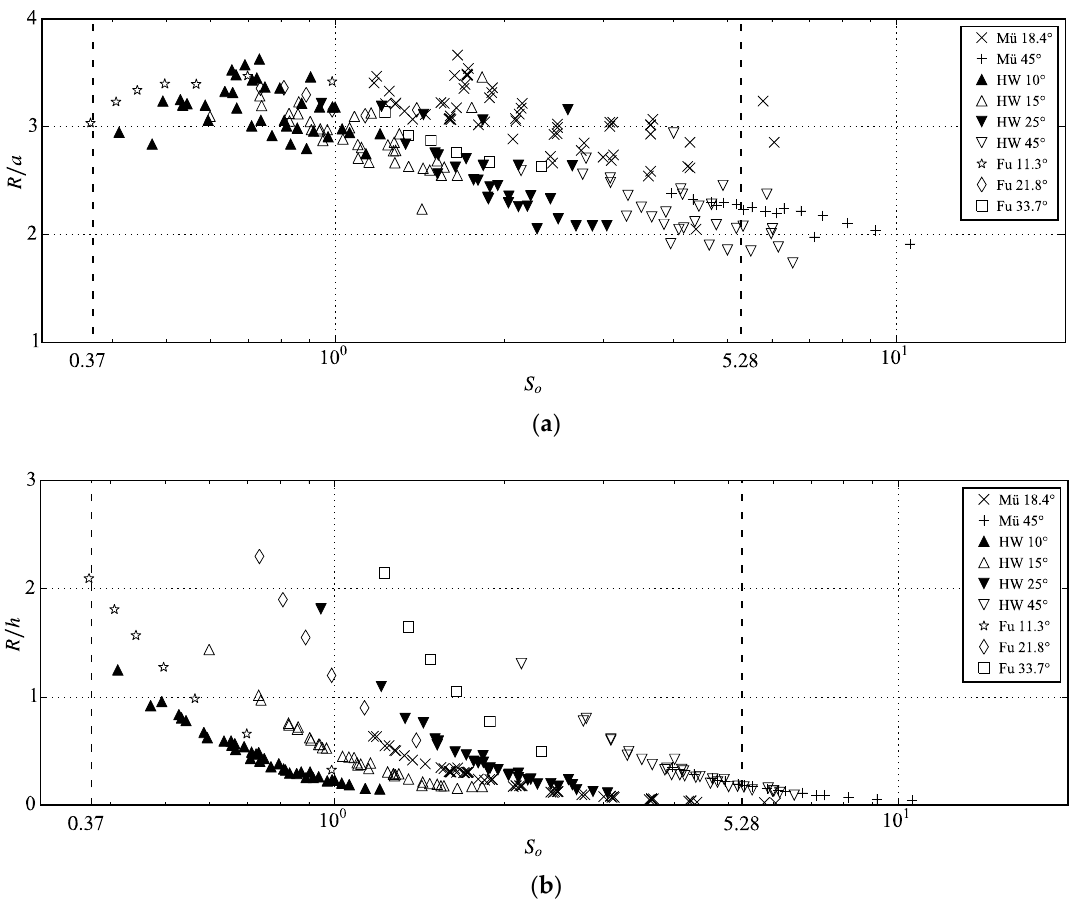
Figure 3. ( a ) Runup height over wave amplitude R / a and ( b ) runup height over stillwater depth R / h versus slope parameter S o for experiments from data sources from Müller (Mü) [7] (without β = 90°), Hall and Watts (HW) [14], and Fuchs (Fu) [20].